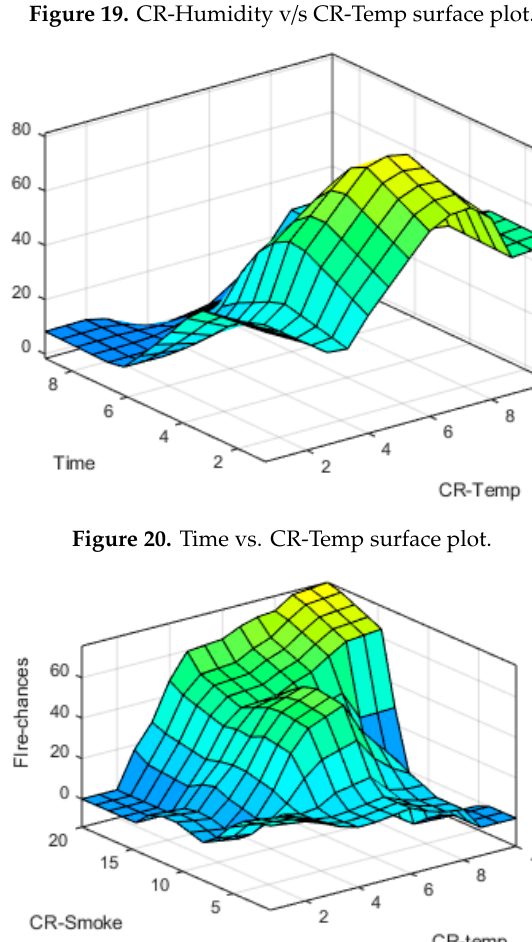
Figure 21. CR-Smoke vs. CR-Temp surface plot.